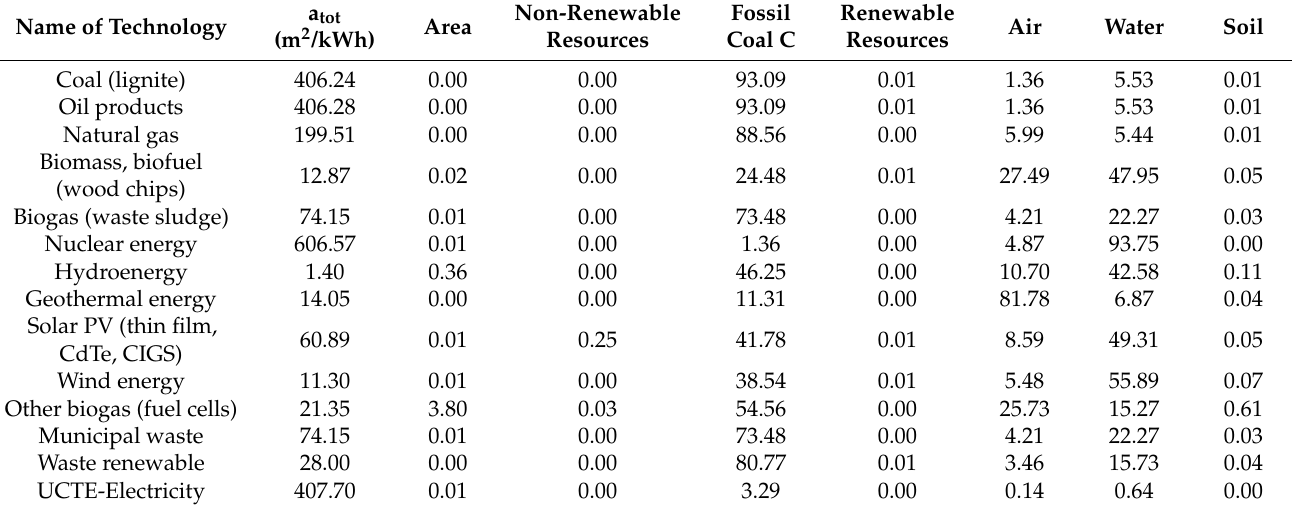
Table 1. Environmental impacts of electricity